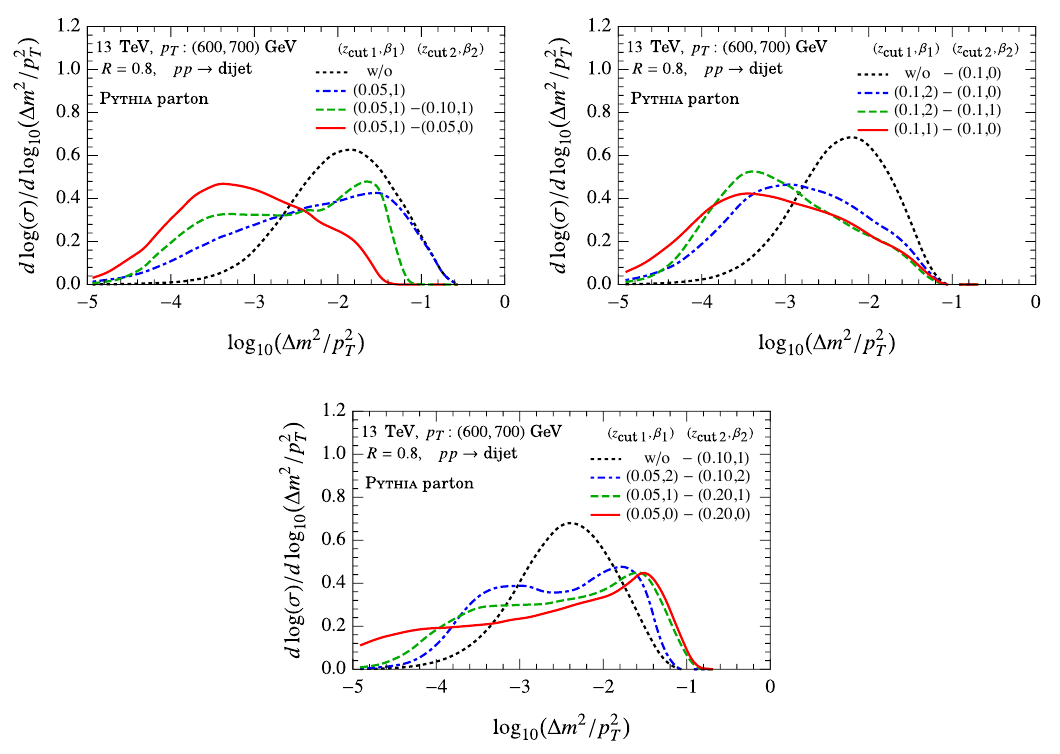
Figure 13 . Pythia collinear drop results for various parameter choices. The top left panel compares collinear drop to the soft drop and ungroomed partonic jet mass spectra analogous to the NLL SCET results in the right panel of (cid:12)gure 9, while the remaining two (cid:12)gures show partonic results for 8 choices of collinear drop parameters analogous to the SCET results in (cid:12)gure